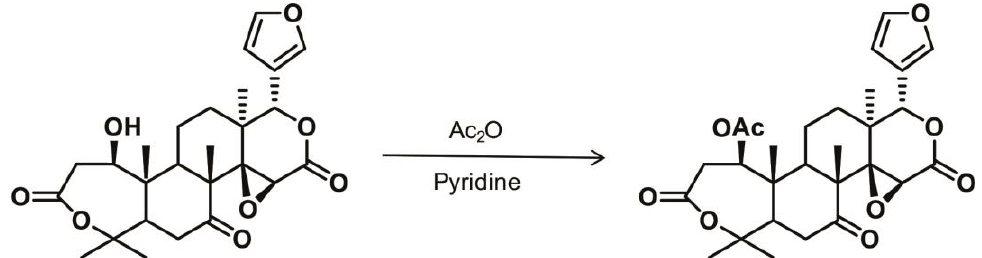
Figure 2. Chemical synthesis of